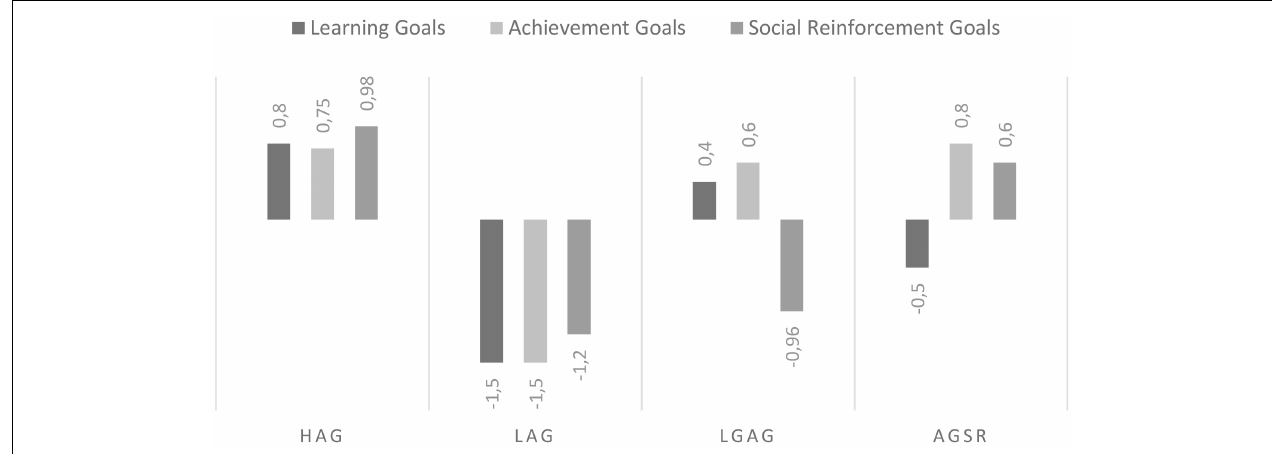
FIGURE 1 | Graphic representation of the Latent Class Analysis solution. Cluster 1 (High Academic Goals; HAG), Cluster 2 (Low Academic Goals; LAG), Cluster 3 (Learning Goals and Achievement Goals; LGAG) and Cluster 4 (Achievement Goals and Social Reinforcement Goals; AGSR).